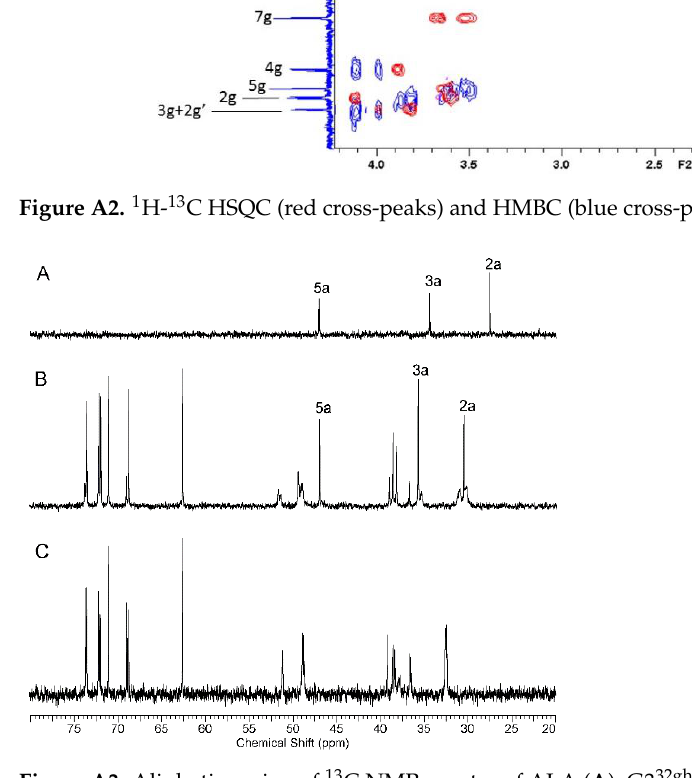
Figure A3. Aliphatic region of 13 C NMR spectra of ALA ( A ), G3 32gh an d 8 equivalents of ALA ( B ), and G3 32gh ( C ) in D 2 O.